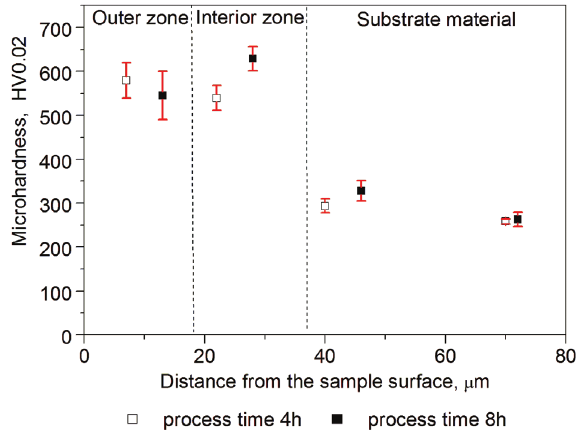
Figure 11: Microhardness changes on the aluminide coating on the cross section made with the CVD method for the processing times of 4 h and 8 h.